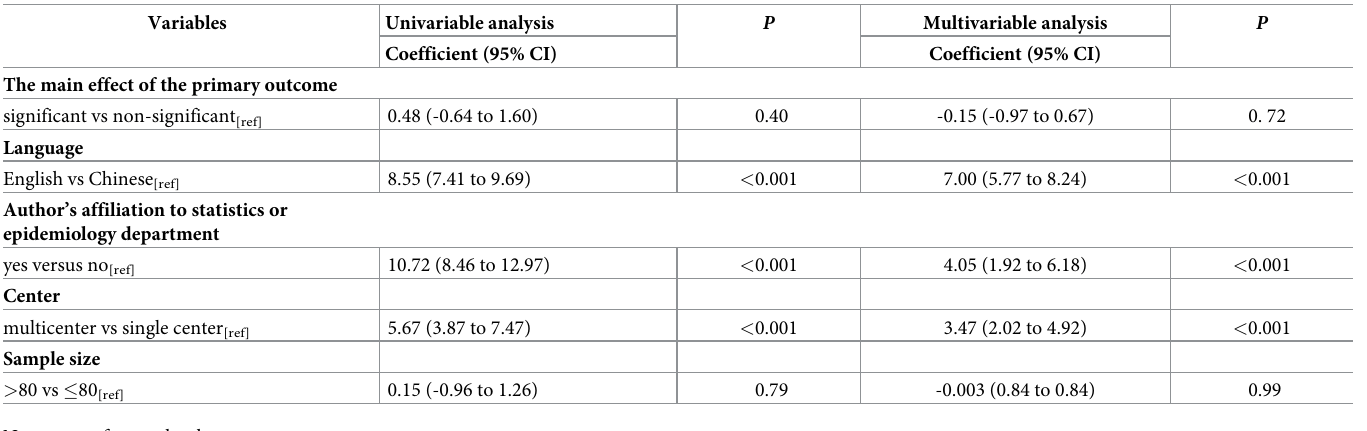
Table 5. Factors associated with the standard